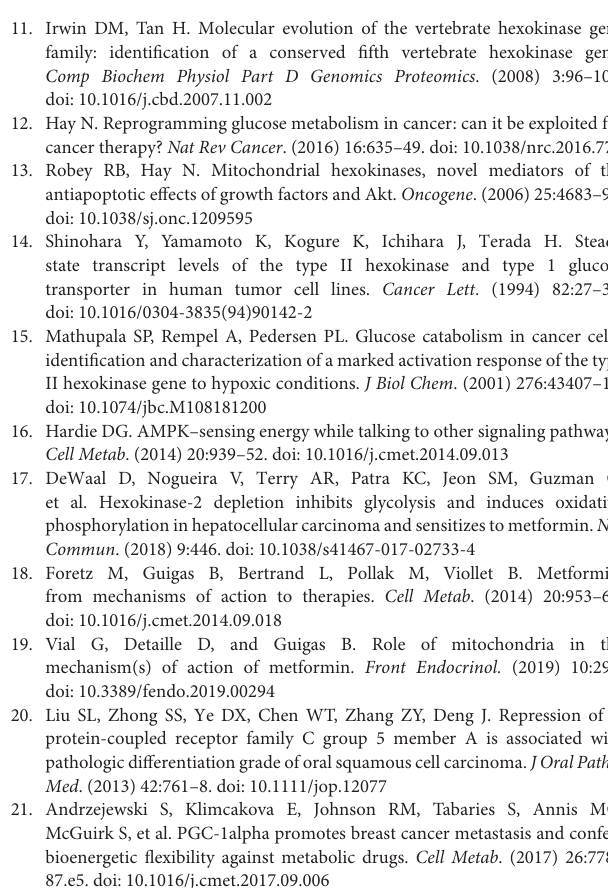
Supplementary Figure S1 | HK2 is high expression in SCC compared to ADC. Supplementary Figure S2 | HK2 is required for lung squamous tumorigenesis. Supplementary Figure S3 | Inhibiting HK2 induces the activation of AMPK signaling pathway. Supplementary Figure S4 | Effect of HK2 knockdown and metformin on cell death and tumor growth. Supplementary Data 1 | Different Gene (fold>2 p